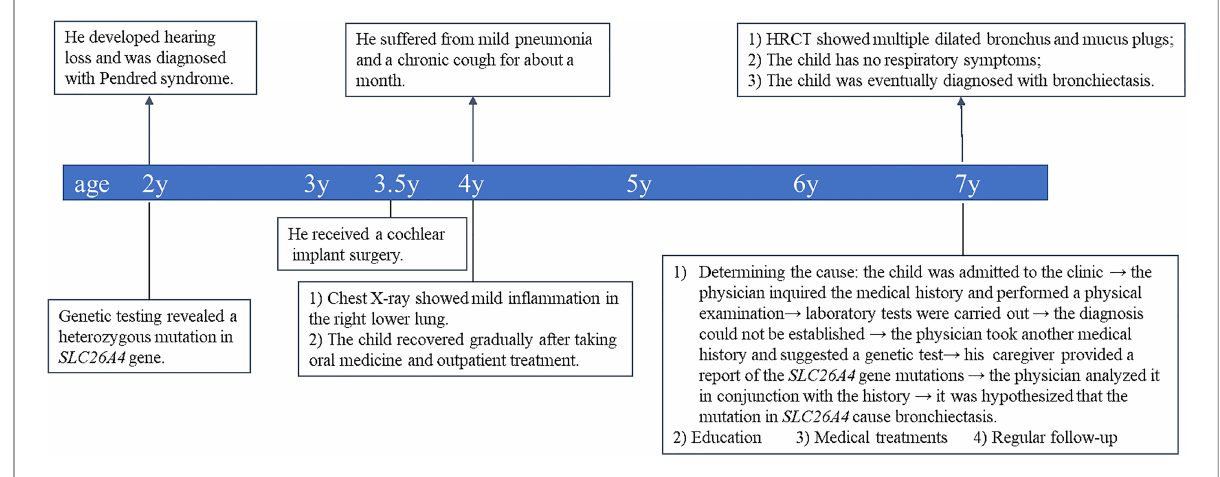
FIGURE 3 Timeline of clinical events, diagnostics, and treatments of the